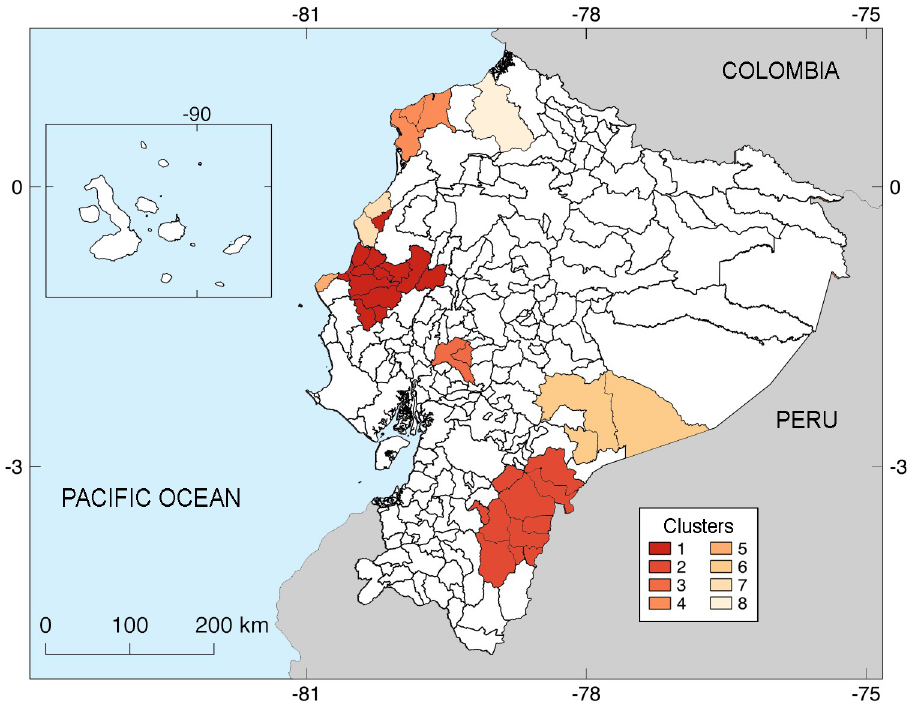
Fig 6. Clusters identified at the canton level of Ecuador based on the cumulative incidence. The color ramp on the lower right comprises the spectrum of spatial clusters for the total incidence. This spatial analysis identified cantons with the highest numbers of hospitalized cases (No. 1, bright red) and those with the lowest number (No. 7, pale orange). Numbers represent the following cantons: No. 1 : Junı´n, Bolı´var, Tosagua, Portoviejo, Rocafuerte, Santa Ana, Sucre, Pichincha, Jaramijo´, Olmedo, 24 de Mayo, and Empalme; No. 2 : El Pangui, Yantzaza, Gualaquiza, Paquisha, Centinela del Co´ndor, Zamora, O ñ a, Sı´gsig, San Juan Bosco, and Limo´n Indanza; No. 3 : Babahoyo and Montalvo; No. 4 : Atacames, Esmeraldas, and Muisne; No. 5: Manta; No. 6 : Taisha, Morona, and Logro ñ o; No. 7 : Jama and San Vicente; No. 8 : Eloy